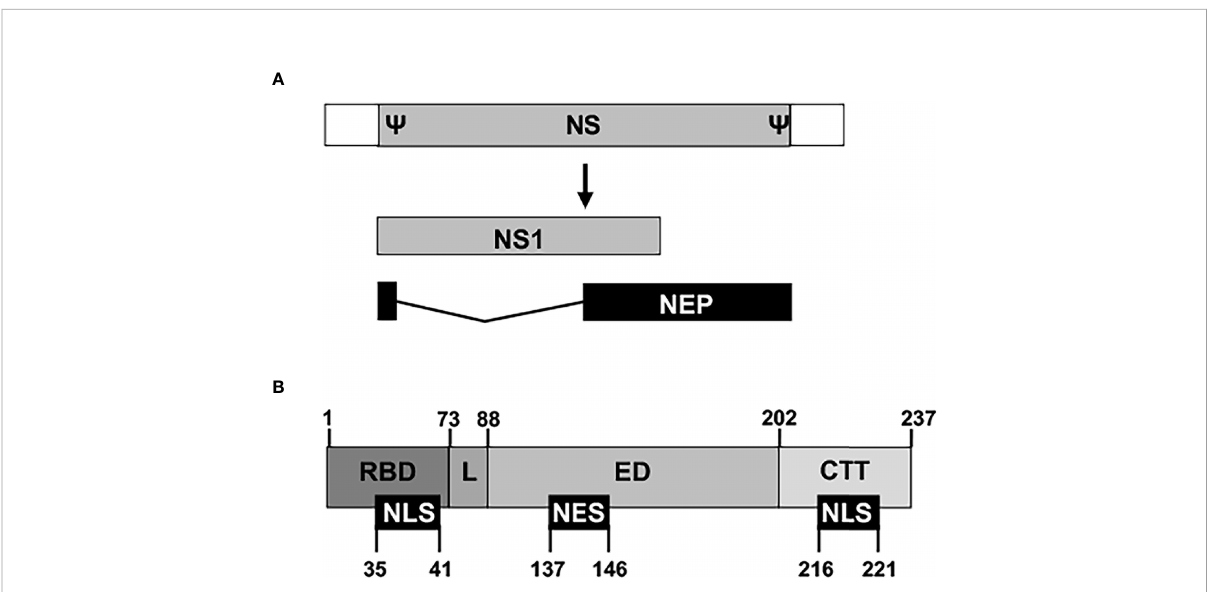
FIGURE 3 Schematic representation of NS segment and NS1 domains. (A) An IAV NS vRNA segment is shown by a gray box and non-coding regions (NCR) are indicated with white boxes. Packaging signals ( Y ) at the end of the 3 ′ and 5 ′ coding regions are also indicated. IAV NS1 and NEP transcripts are indicated with gray and black boxes, respectively. IAV NS1 and NEP ORFs share the fi rst 10 amino acids in the N-terminus. (B) The NS1 protein is divided into four regions: The N-terminal RNA-binding domain (RBD; amino acids 1 – 73), the linker sequence (L; amino acids 74 – 88), the effector domain (ED; amino acids 89 – 202), and the C-terminal tail (CTT; amino acids 203-219/230/237). Note that both the L and the CTT can vary in length among different IAV strains, and, although a 237 amino-acids-length NS1 has been represented, IAV NS1 can be 219, 230, or 237 amino acids long. Nuclear localization and export signals (NLS and NES, respectively) are indicated with black boxes at the bottom, including their amino acid locations in the